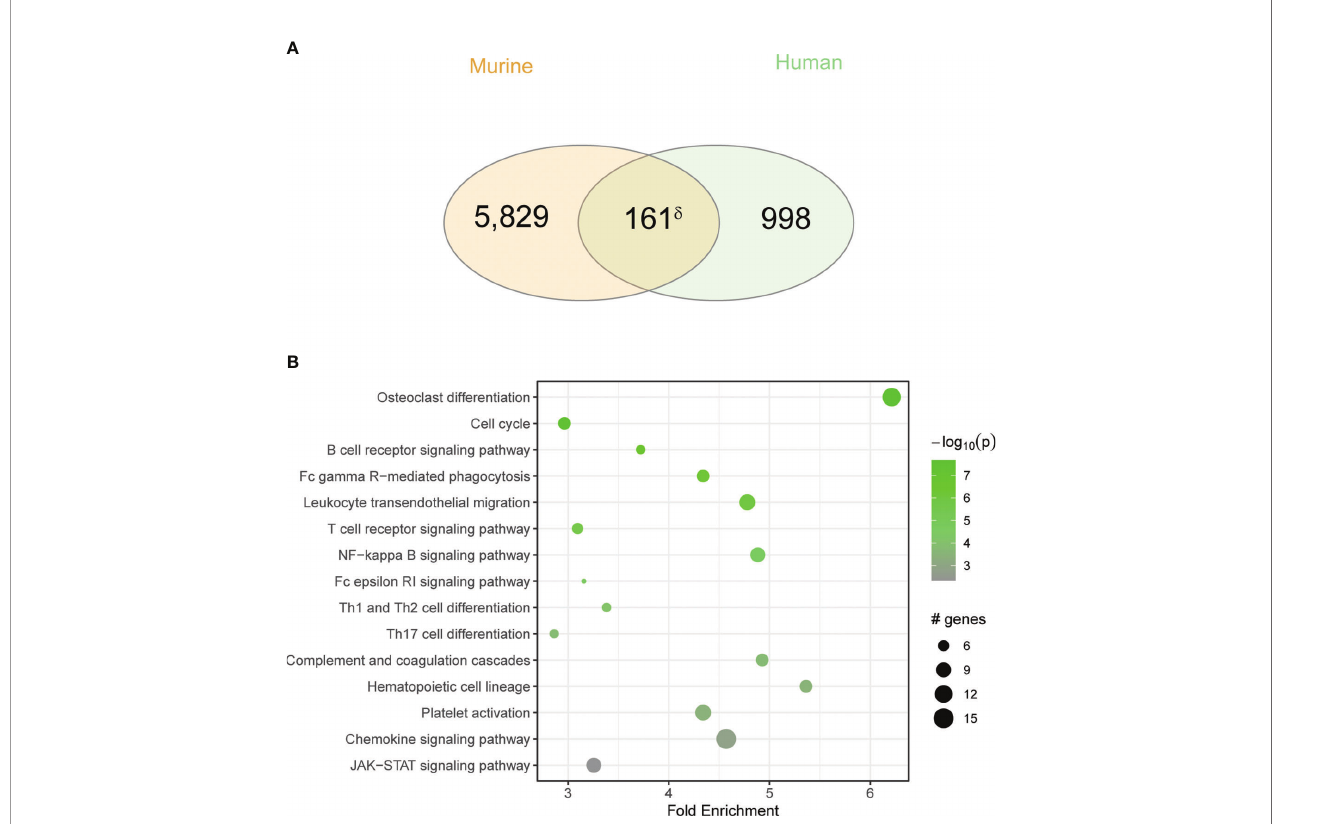
FIGURE 4 | Overlap between human CRS and chronic fungal challenged mouse sinus gene expression is enriched for in fl ammatory pathways. (A) Venn diagram showing the overlap between DEGs in the murine model to the CRS gene signature. (B) KEGG pathway enrichment analysis of overlapping genes. d p < 5e-10 by hypergeometric